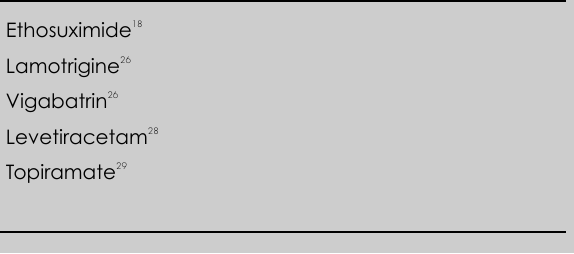
Table I. Drugs implicated in forced normalisation